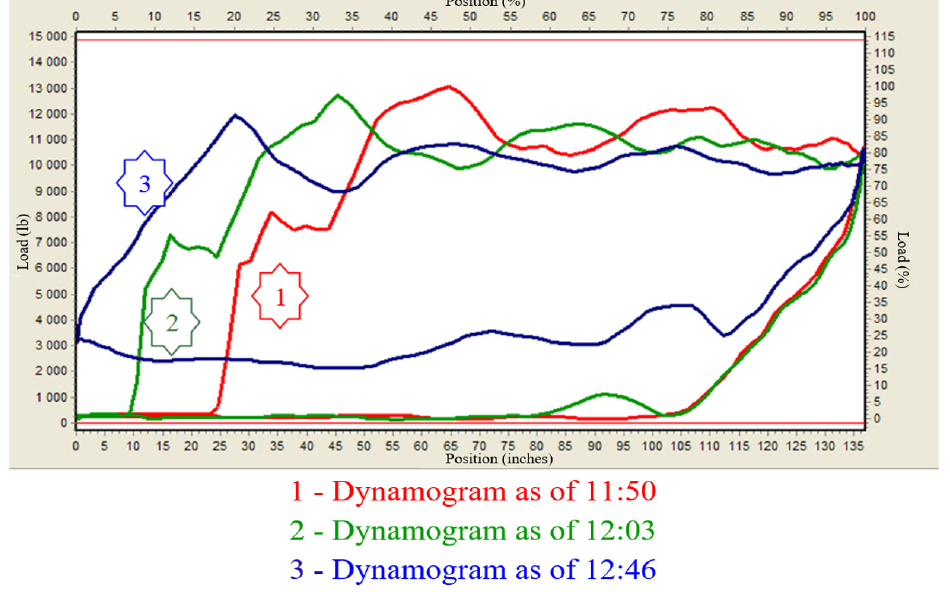
Figure 8. Well performance recovery history after annular gas extraction.